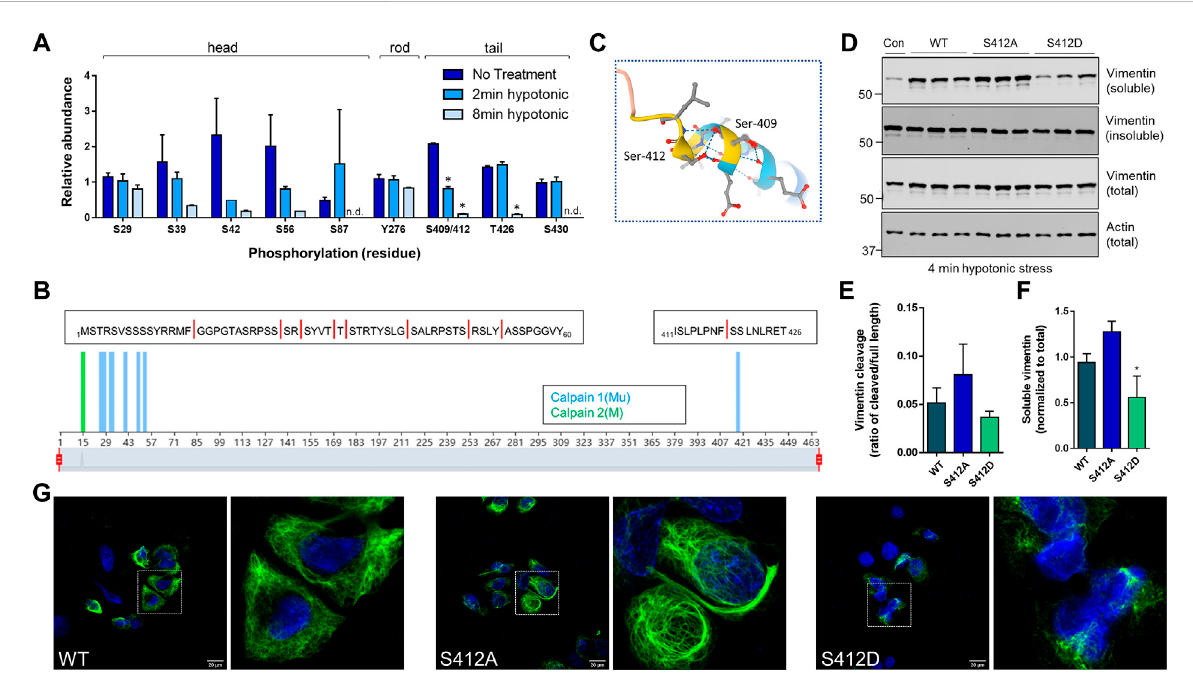
FIGURE 5 Site-speci fi c and time-dependent dephosphorylation in response to hypotonic stress regulates vimentin solubility. (A) Mass spectrometry analysis for phosphorylation site changes on vimentin in GAN fi broblasts after 2 min and 8 min of hypotonic stress exposure. * p < 0.001; Multiple t-tests. (B) PredictiveanalysisofcalpaincleavagesitesonvimentinusingtheDeepCalpaintool.PeptidesequencesspantheN-terminalheaddomain (aa1-60), containing eight predicted cut sites (red lines) and C-terminal tail domain peptide (aa411-426) containing a single predicted cut site. (C) Model of vimentin rod/tail junction (AlphaFold) with the localization of Ser-409/412. (D) Immunoblotting for vimentin (top, middle) and actin (bottom; loading control) in Triton X soluble (top), Triton X insoluble (middle top), and total cell (middle bottom, bottom) lysates from BHK-21 cells transfected with WT, S412A, and S412D constructs and exposed to hypotonic stress for 4 min. (E,F) Quanti fi cation of vimentin cleavage (E) and solubility (F) in WT and mutant vimentin. * p < 0.05; one-way ANOVA. (G) Immuno fl uorescence analysis of SW13 Vim − cells transfected with WT vimentin(left)andvimentinmutantsS412A(middle)andS412D(right)andstainedwithvimentin(green)andDAPI(blue)followinga24-htransfection period; scale bar = 20 μ m. White squares indicate magni fi ed